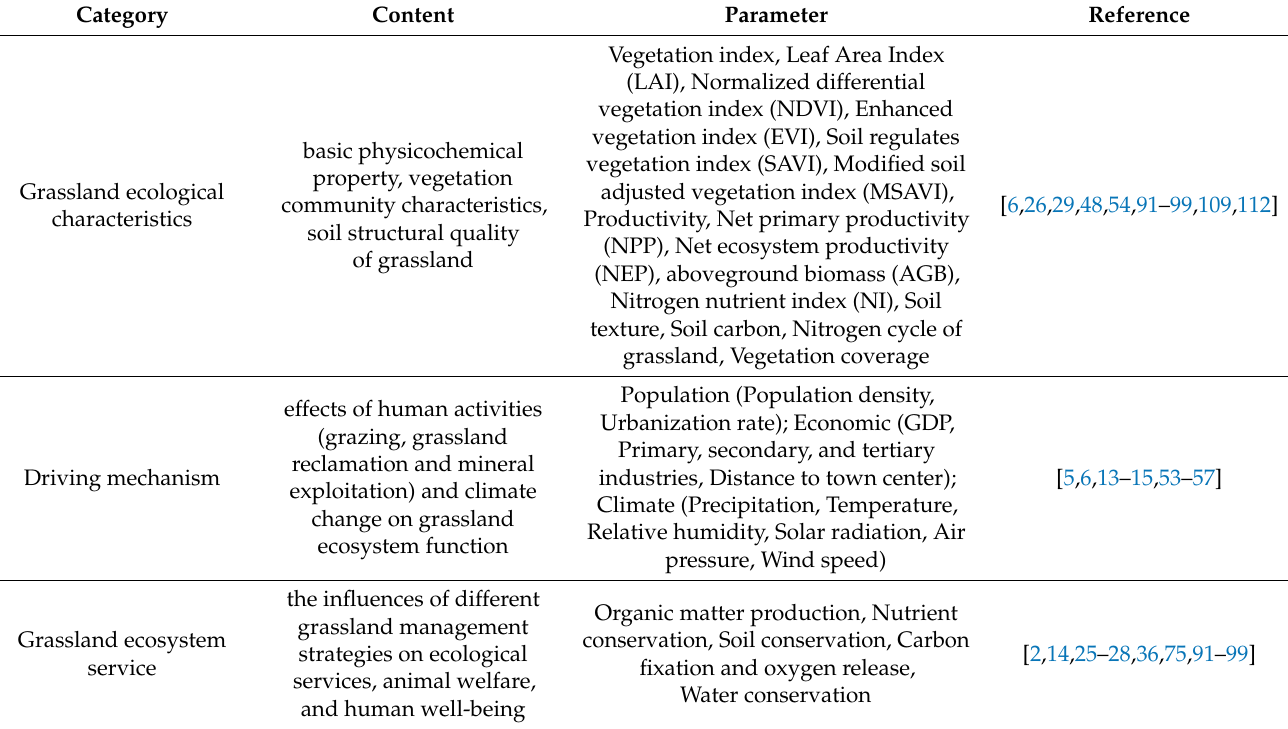
Table 1. Three categories and corresponding parameters targeting grassland